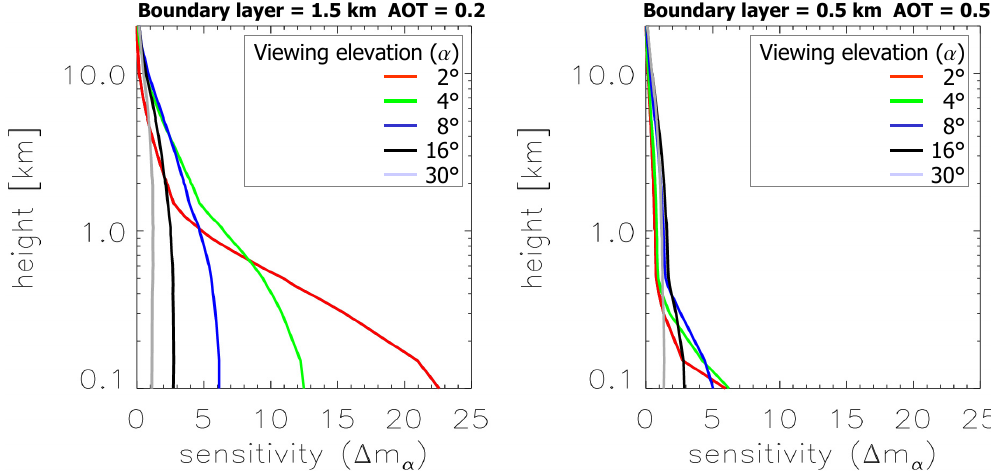
Fig. 1. Height dependent sensitivity to NO 2 (height-dependent differential air mass factors) of MAX-DOAS measurements at five viewing elevations, for two cases: (i) a relatively low amount of aerosols (AOT=0.2) in a boundary layer with a vertical extent from 0–1.5km and (ii) a relatively high amount of aerosols (AOT=0.5) in a boundary layer with a vertical extent from 0–0.5km. SZA=60 ◦ , AZIM=180 ◦ , λ =